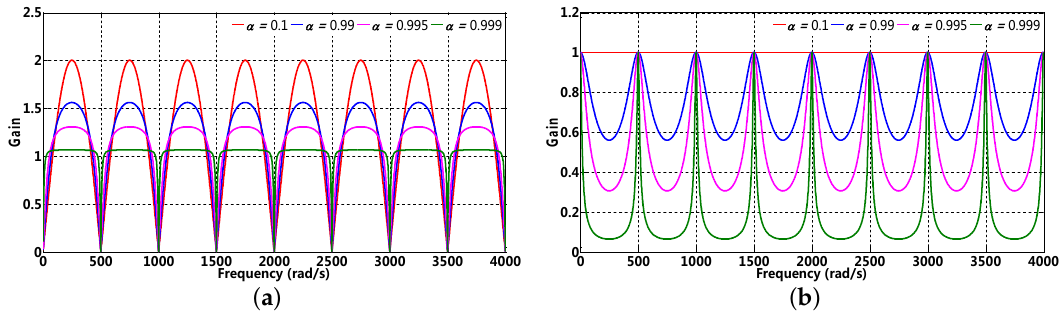
Figure 5. Magnitude gain waveforms with respect to parameter α : ( a ) 1 − Q ( z − 1 ) z − m ; ( b ) Q ( z − 1 )